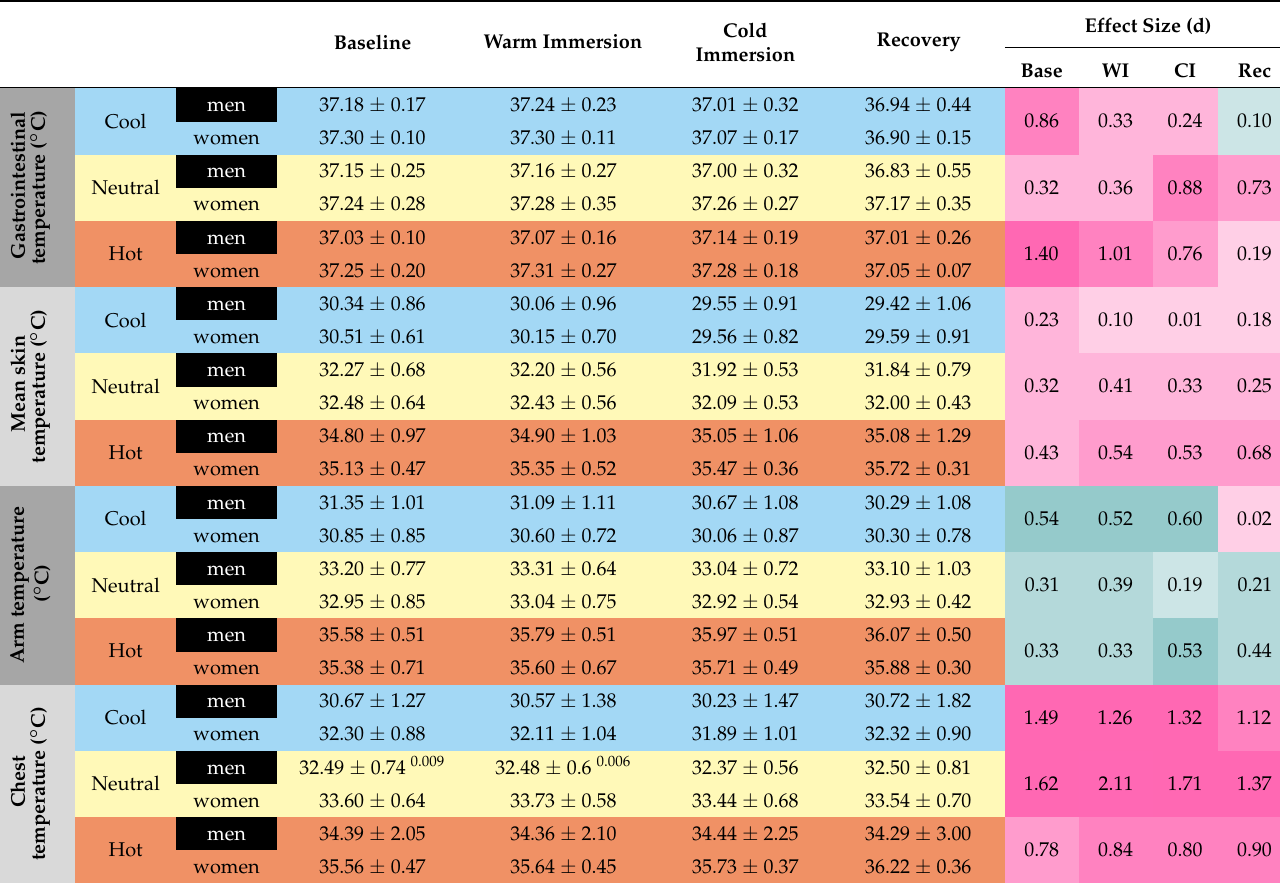
Table A2. Physiological and perceptual parameters across groups and environments. Effect sizes indicate between group